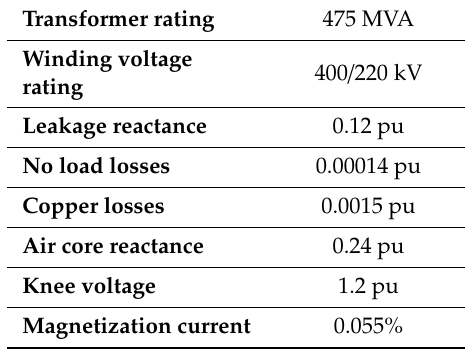
Table A3. The 400 / 220 kV, 475 MVA transformer data implemented in PSCAD.